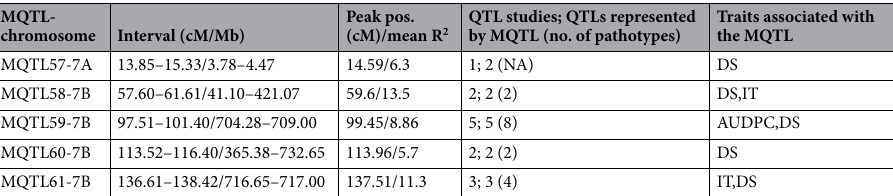
Table 2. A summary of the results of MQTL analysis for stripe rust resistance in wheat. NA not available, AUDPC area under disease progress curve, IT infection type, DS disease severity, SR stripe rust response, NDVI normalized difference vegetation index, LP latency period, RT reaction type, IR infection response.